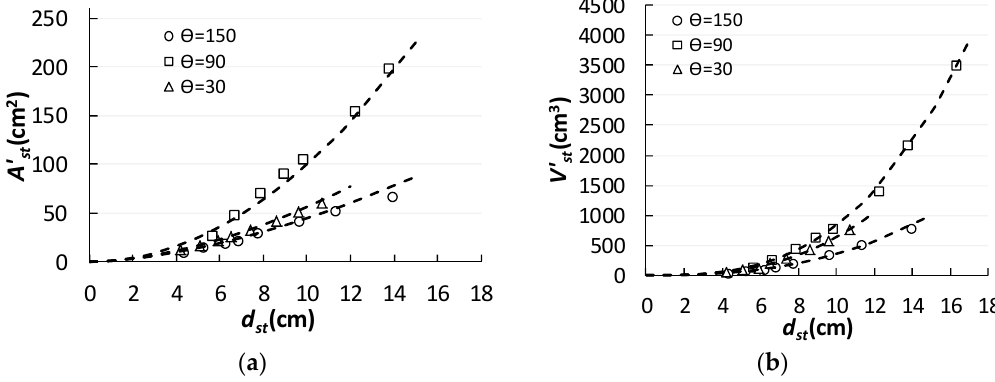
Figure 4. The difference of scour hole geometrical evolution velocity ( a ) the plane area of scour hole ( b ) scour hole-volume.